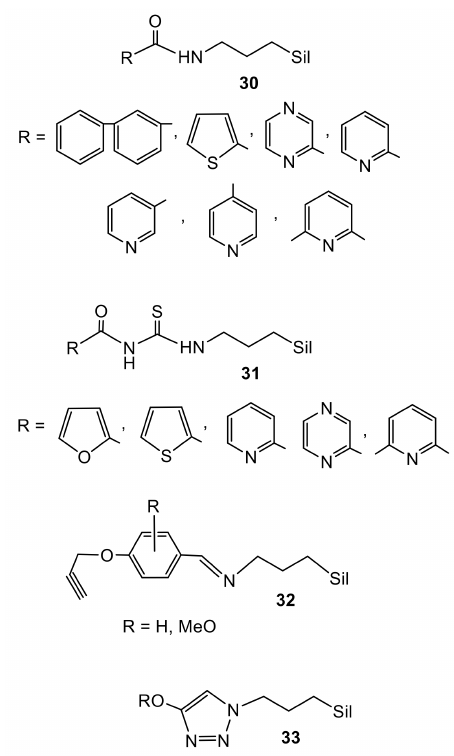
used for the recognition of various ions. For example, triazolylsilatranes ( 33 ) showed good with respect to Ag + (Figure 9) [69].